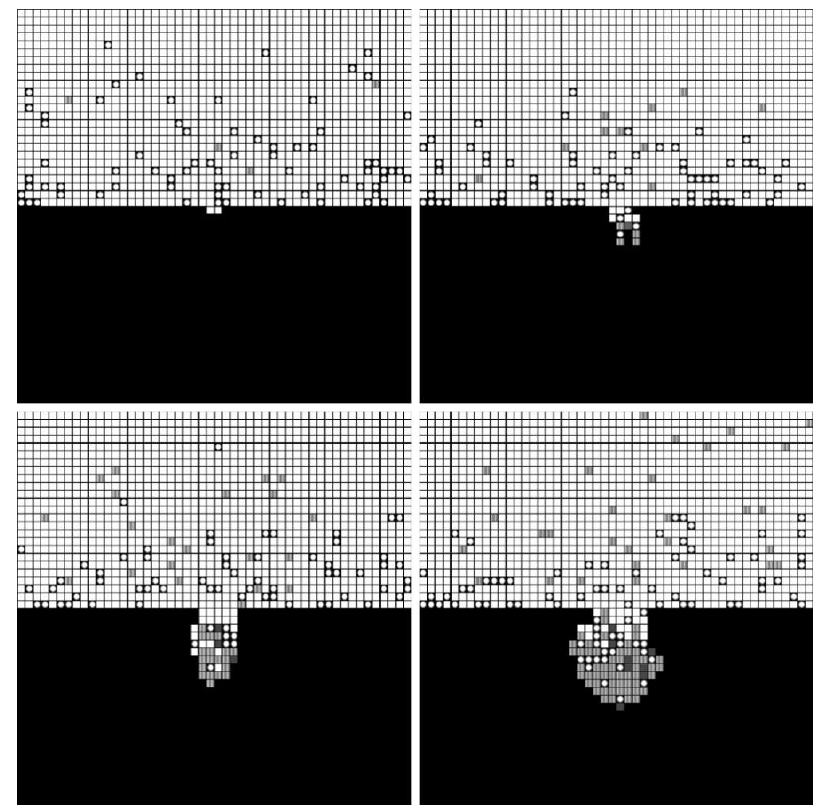
Figure 5. Simulation results under 5 V.